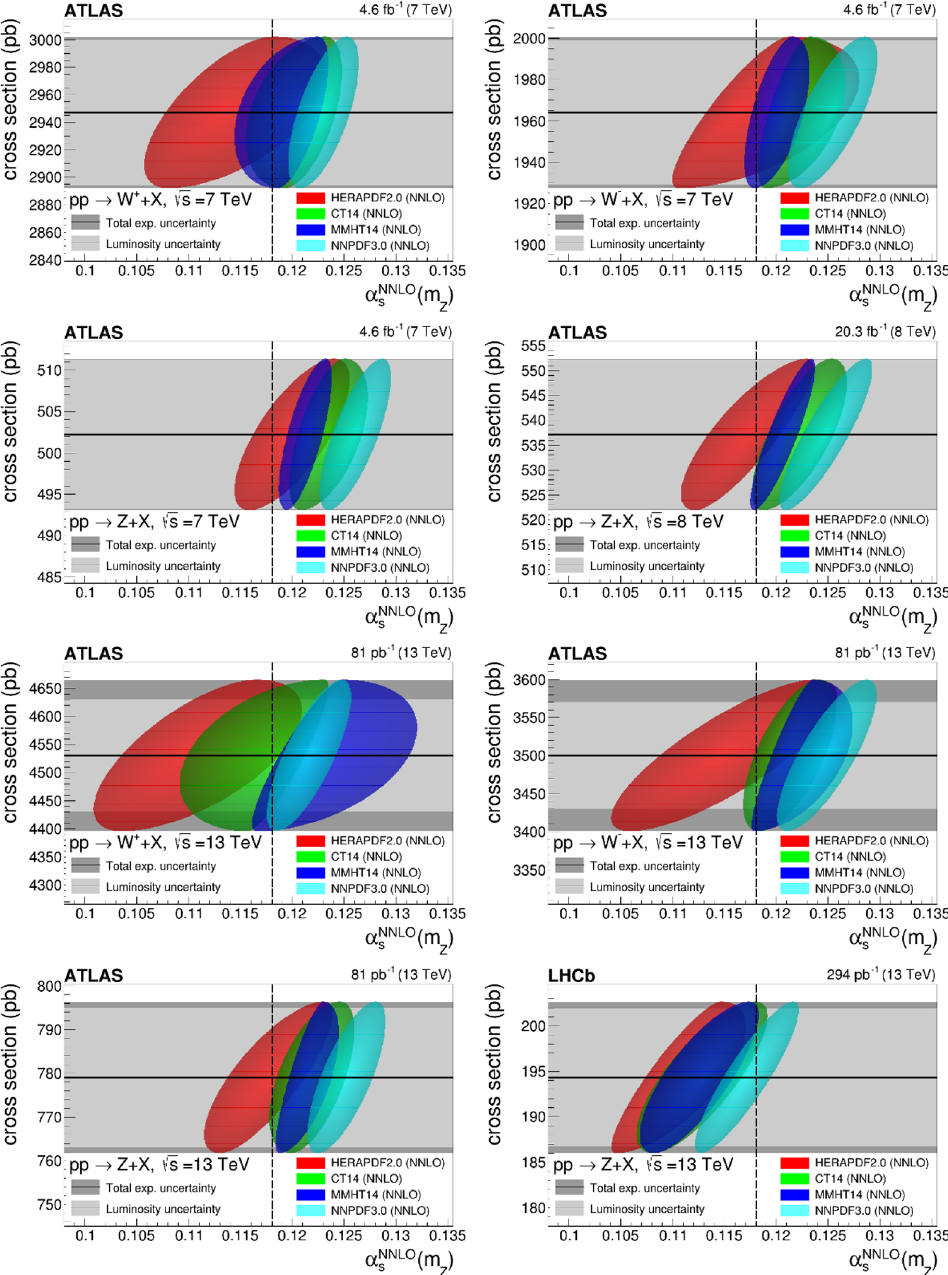
Figure 1 . Data-theory comparison of the ATLAS (cid:12)ducial cross sections for W + (upper left), W (cid:0) p (upper right), and Z (second row, left) boson production in pp collisions at s = 7 TeV, for Z p bosons at s = 8 TeV (second row, right), for W + (third row, left), W (cid:0) (third row, right), and Z p p (bottom left) bosons at s = 13 TeV, and for the LHCb Z boson at s = 13 TeV (bottom right). The experimental cross sections are plotted as horizontal black lines with outer darker (inner grey) bands indicating their total (integrated luminosity) uncertainties. The theoretical predictions are computed for each PDF set as a function of (cid:11) s ( m Z ), x axis, and combined with the experimental results into Jpdfs shown as (cid:12)lled ellipses. The vertical dashed line indicates the expected predictions for (cid:11) s ( m Z ) = 0 : 118.